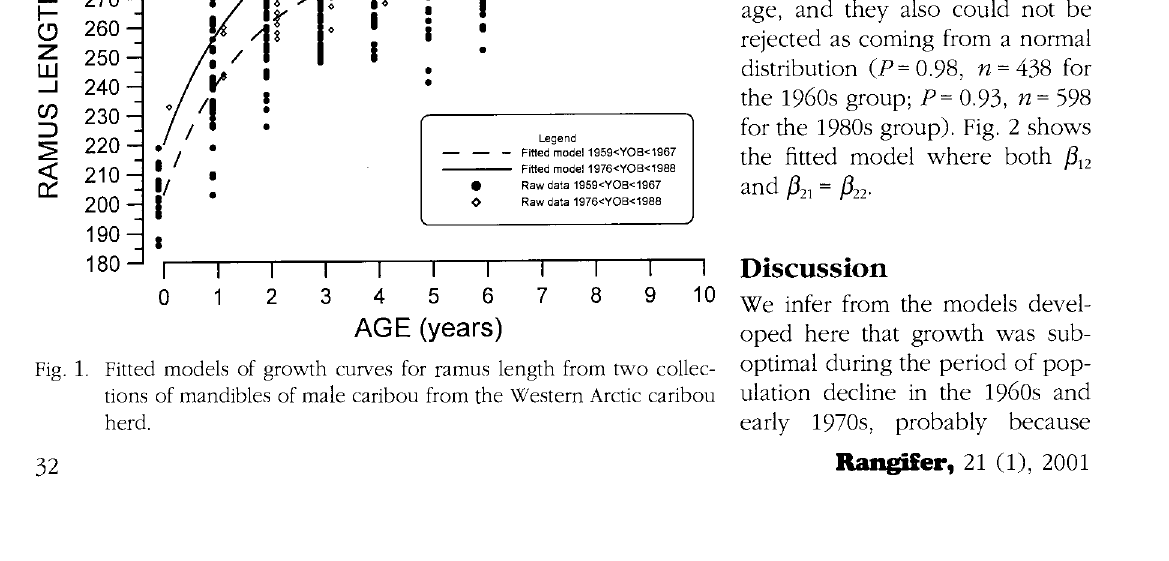
Fitted models of growth curves for ramus length from two collec Fig. 1. tions of mandibles of male caribou from the Western Arctic caribou 32